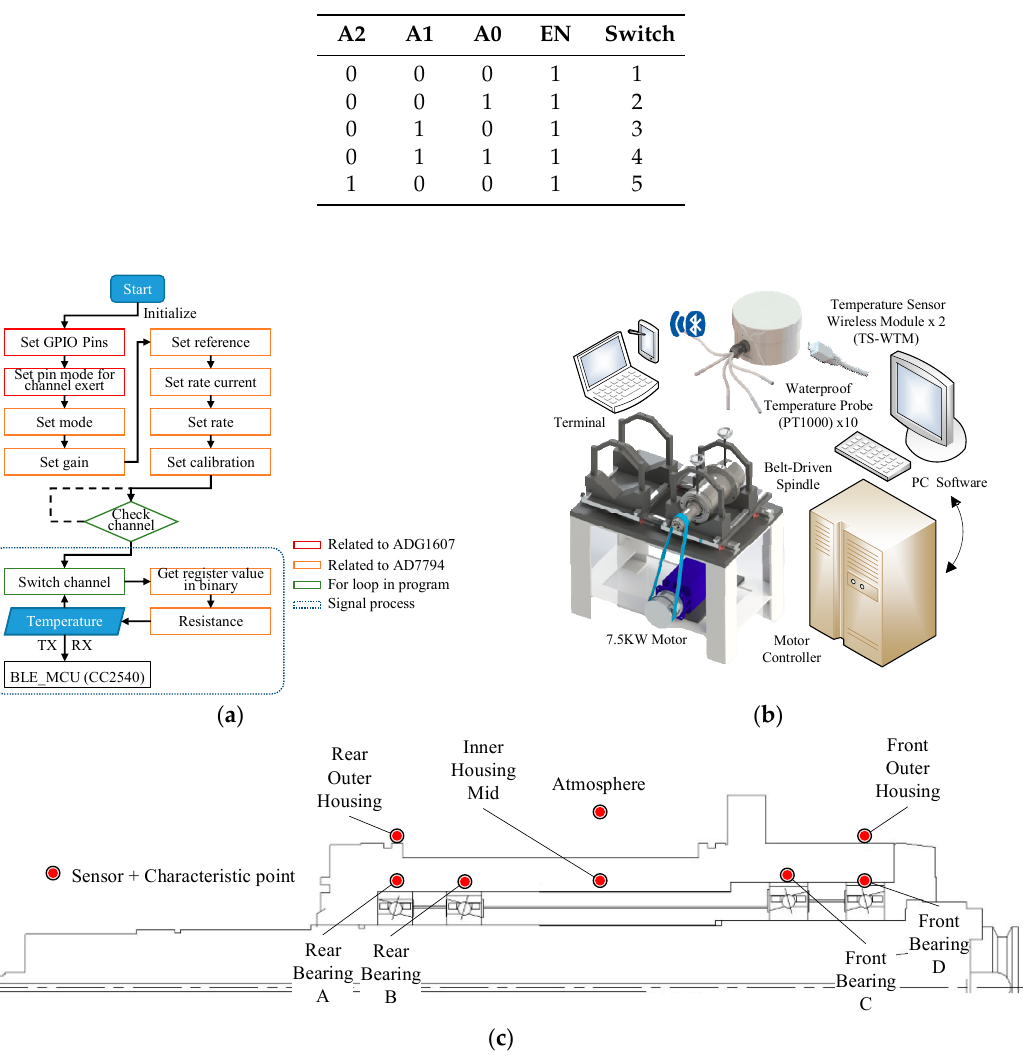
Figure 3. ( a ) Signal transform firmware flow chart; ( b ) Experiment setup schematic; ( c ) Sensor location and characteristic points on the spindle.